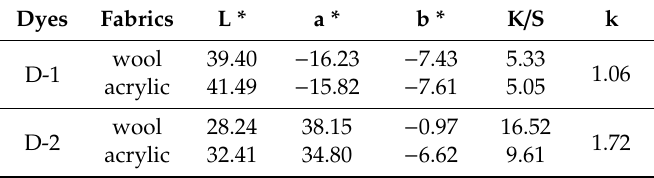
Table 3. The union dyeing performance of wool and acrylic